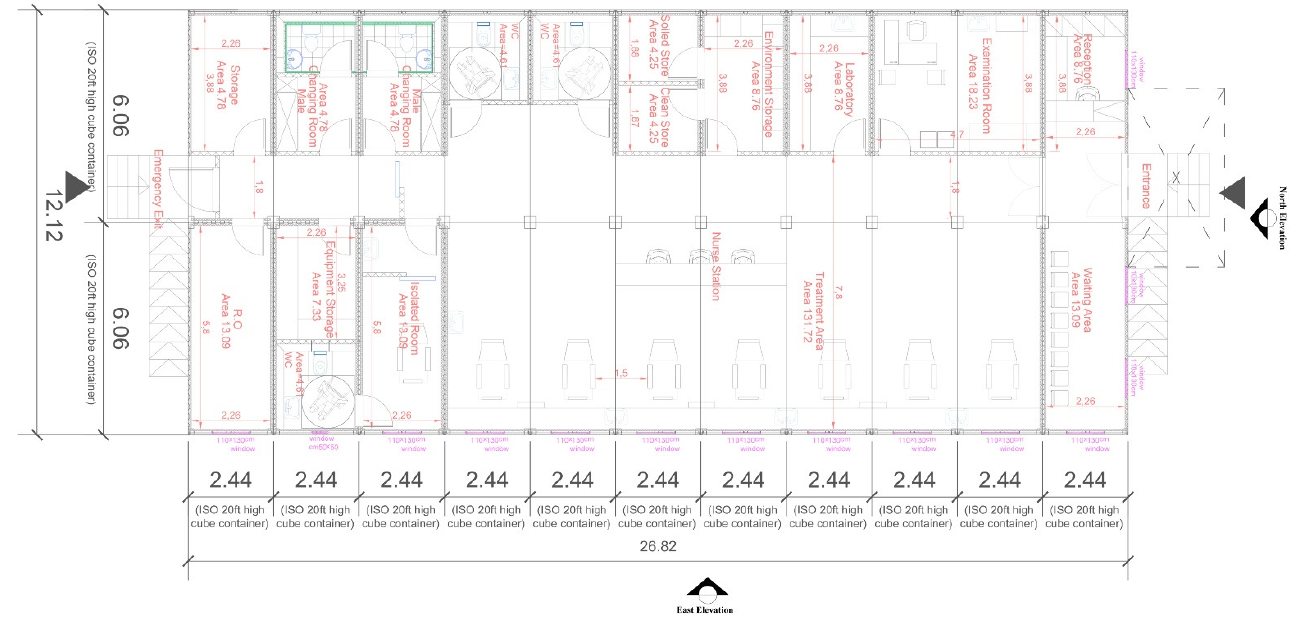
Figure A3. Dialysis department plan of the relocatable hospital in Mosul.